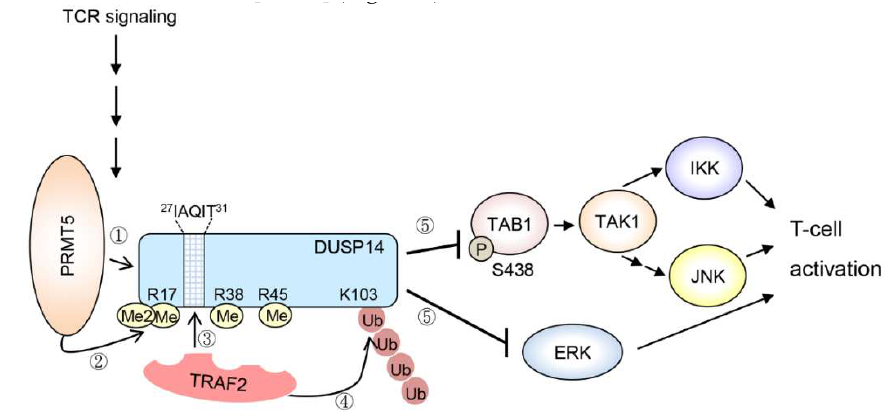
Figure 1. Upon T-cell receptor (TCR) signaling, the protein arginine methyltransferase PRMT5 interacts with DUSP14 and induces its methylation on Arg17, Arg38, and Arg45 residues. Arginine-methylated DUSP14 then interacts with the ubiquitin E3 ligase TRAF2, which binds to the motif containing IAQIT residues of DUSP14 and then promotes K63-linked ubiquitination on Lys103 residue of DUSP14. Methylation and subsequent ubiquitination enhance the phosphatase activity of DUSP14. Activated DUSP14 dephosphorylates TAB1, leading to sequential inactivation of TAK1 and downstream IKK/JNK activities. Activated DUSP14 also directly dephosphorylates ERK and attenuates the ERK signaling pathway. Arrows denote activation; T bars denote inhibition.